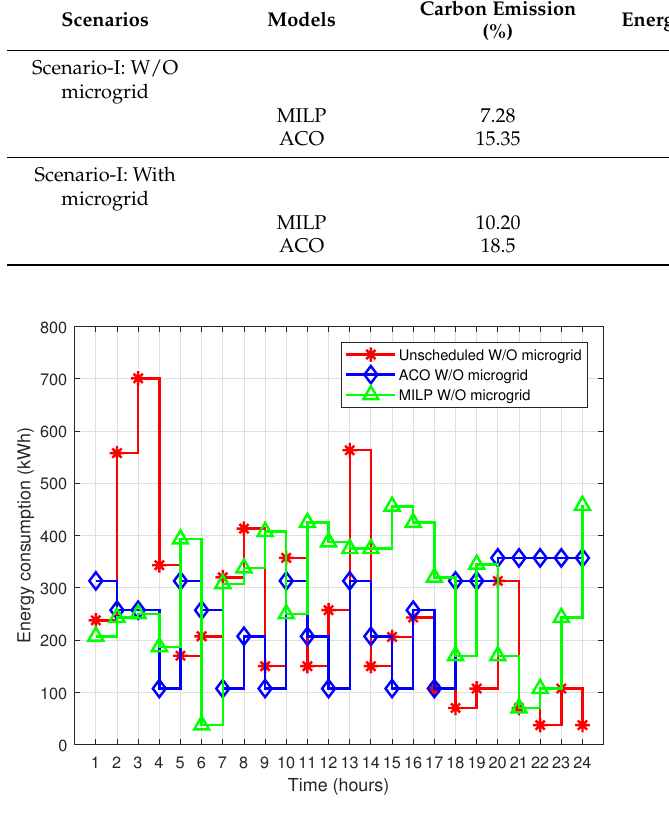
Figure 6. Energy consumption evaluation W/O considering